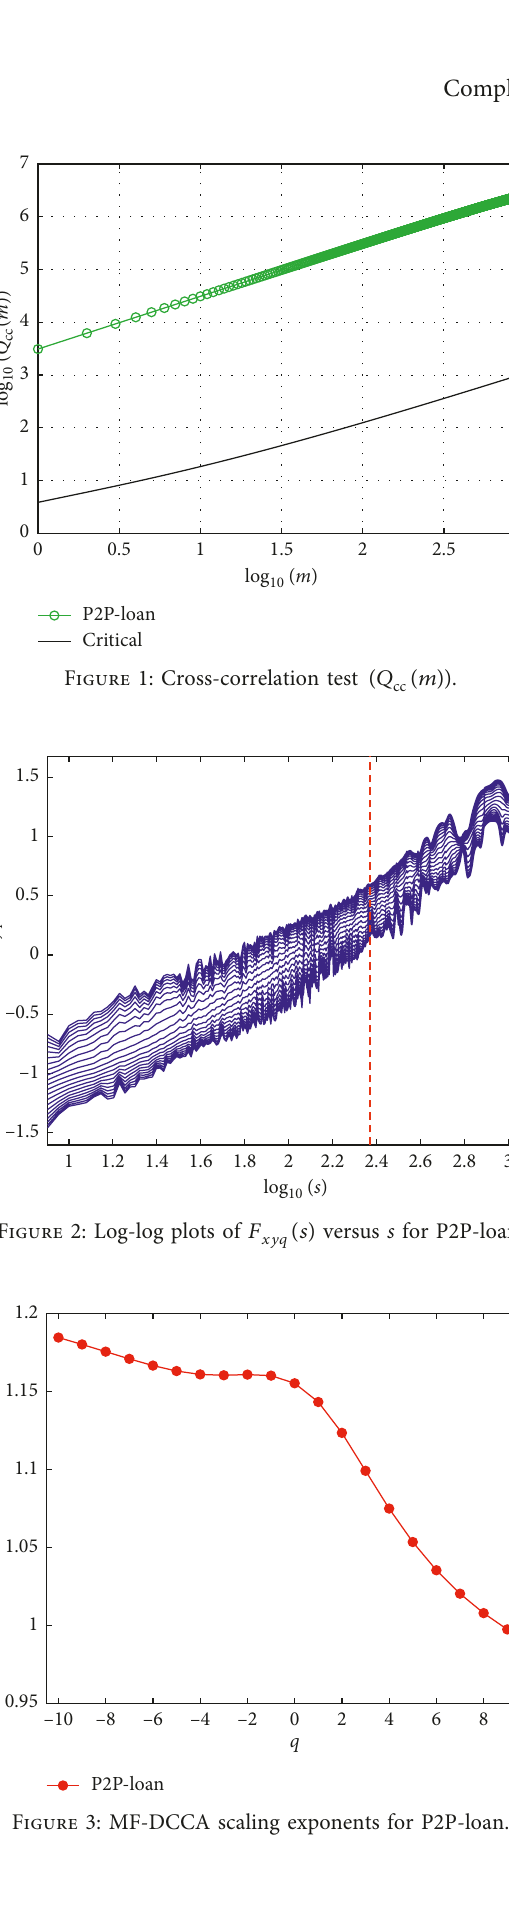
Figure 3: MF-DCCA scaling exponents for